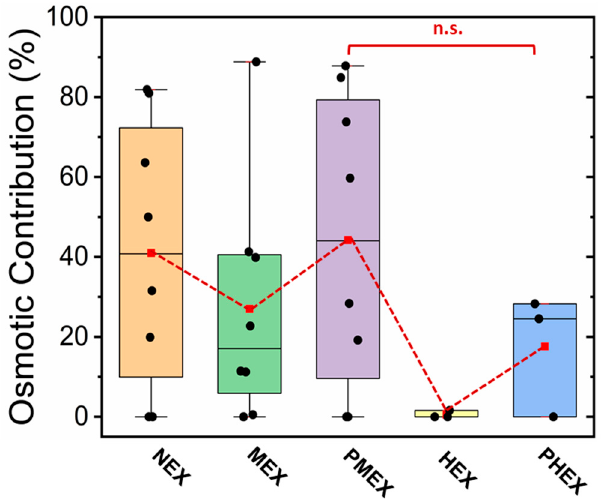
Figure 5. Plot showing the effectiveness of the 4 M glucose hydrogel in facilitating lactate withdrawal via osmosis under different physiological conditions. Each dot denotes data from one subject. The dashed line connects the mean values to guide the eye.